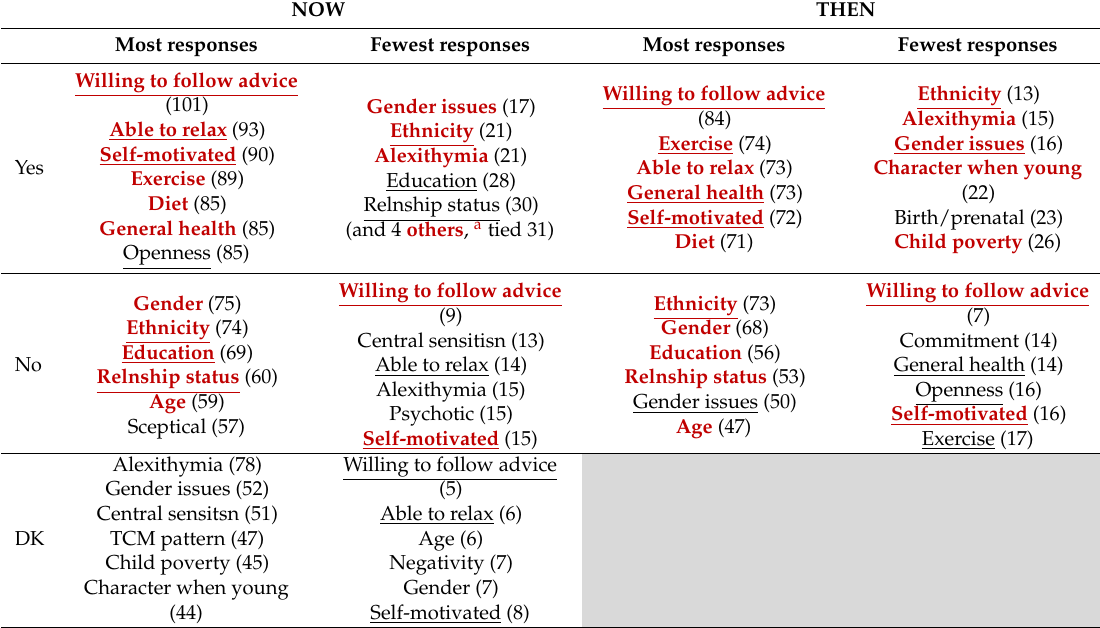
Table 3. “Yes”, “No” and “Don’t know” (DK) responses in the upper and lower deciles for the 60 main survey questions (numbers of responses in brackets). Items shown in bold red type appear in the same deciles both NOW and THEN; those underlined appear in Most “Yes” responses and Least “No” responses (NOW or THEN), or vice versa.